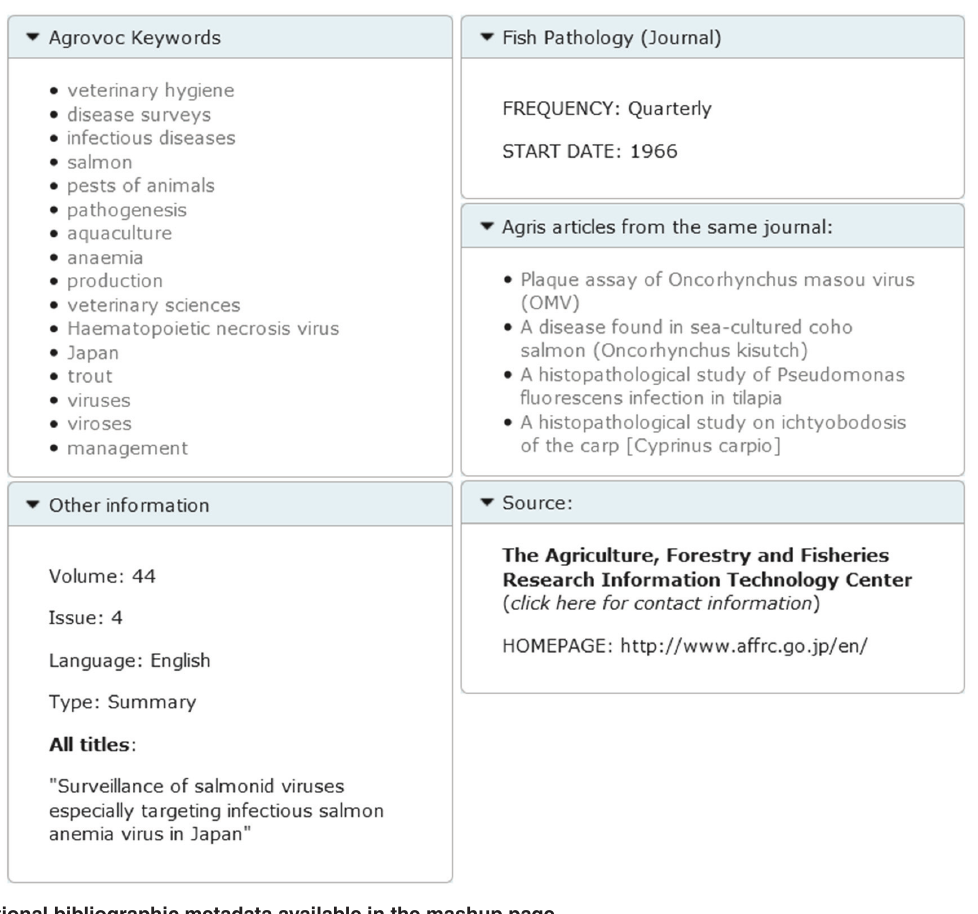
Figure 2. Additional bibliographic metadata available in the mashup page.